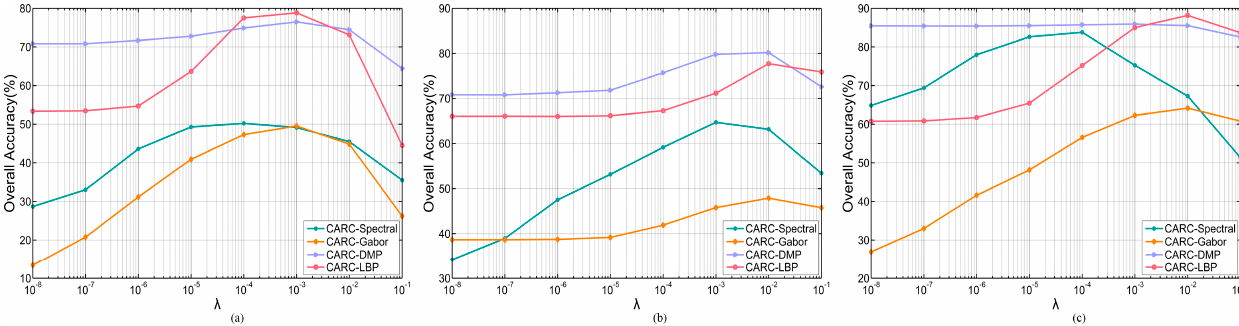
Figure 5. Classification accuracy versus varying λ for the proposed MFCARC and MFCART methods. ( a ) Indian Pines. ( b ) Pavia University. ( c ). Salinas.